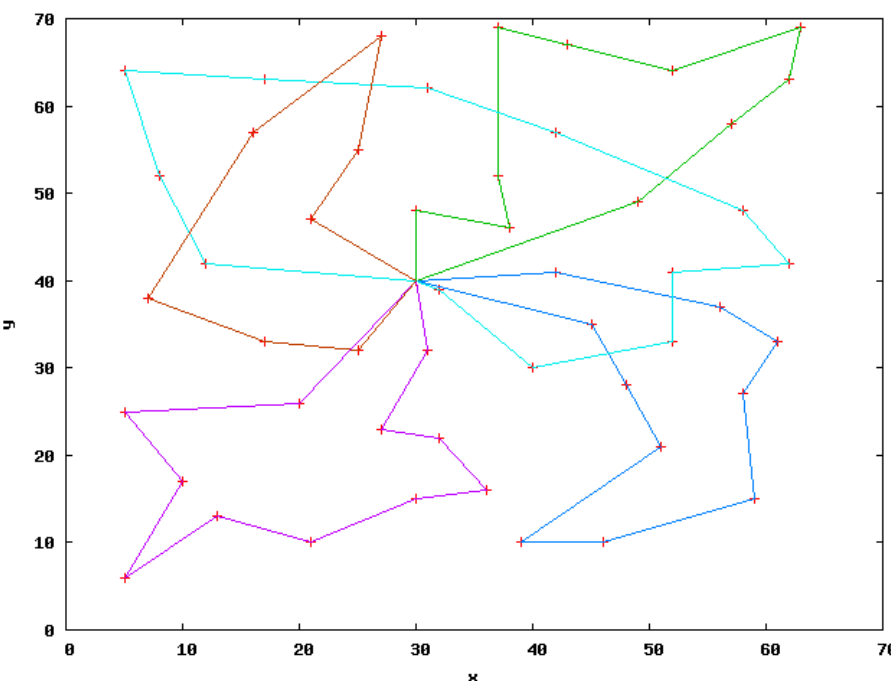
Figure 11. Crossover domination experiment—example for medium Christophides and Eilon set E , fitness distance from best-known one around